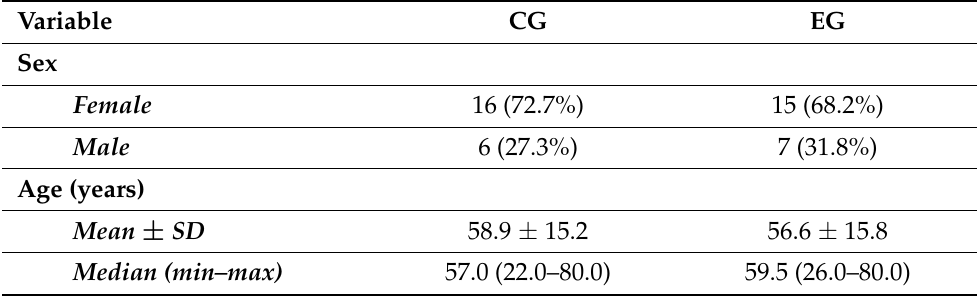
Table 1. Baseline characteristics of two